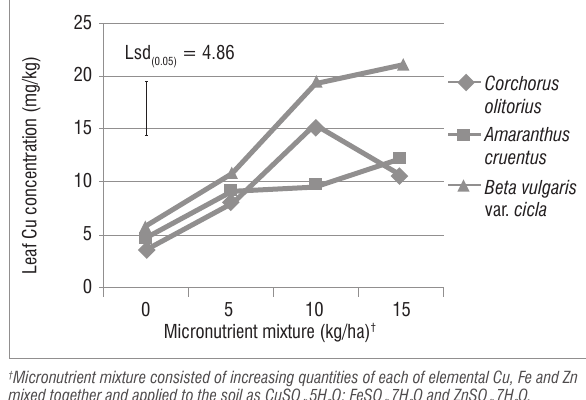
Figure 1: Concentration (mg/kg) of Cu in the leaves of two wild vegetables – Corchorus olitorius and Amaranthus cruentus var. Arusha – and a conventional vegetable, Swiss chard ( Beta vulgaris var. cicla ) after application of 0 kg/ha, 5 kg/ha,